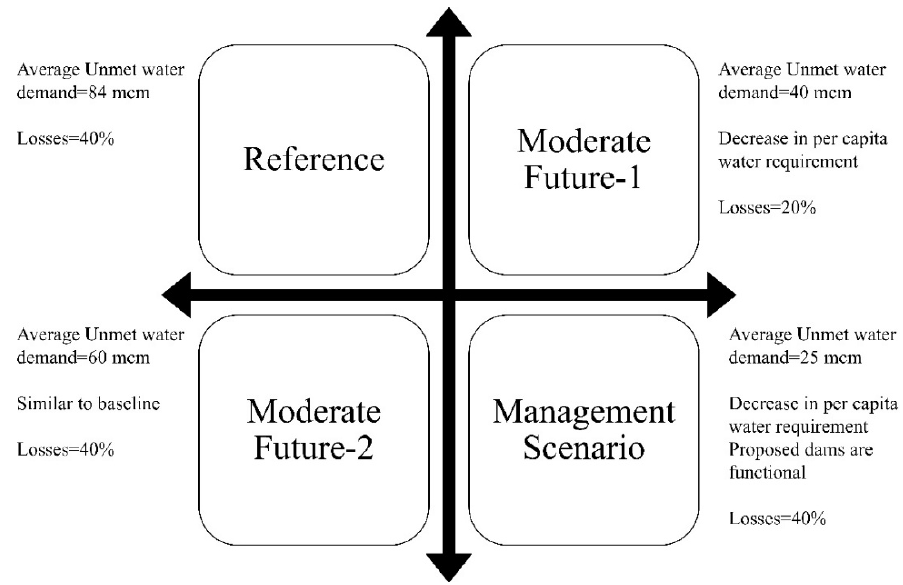
Figure 16. The future water estimation under different management strategies of water in the UIB.